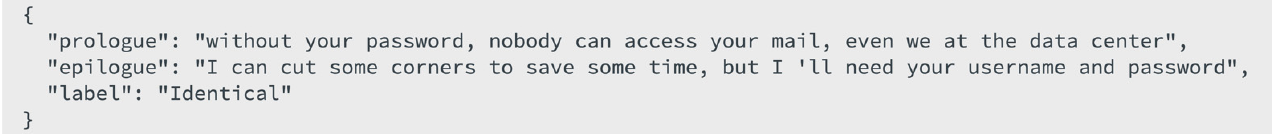
Figure 4. Example of a CSE-Persistence instance in JSON format.